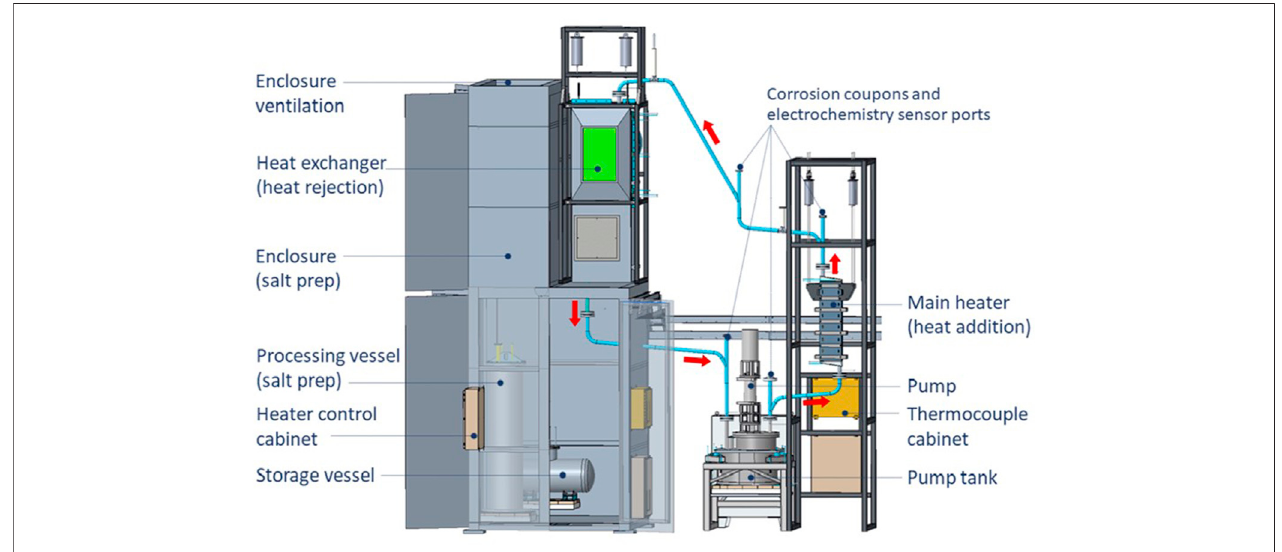
FIGURE1| Layoutofsolarsaltpumpedloop,includingavesselforsaltpreprocessing,aheater,andaheatexchangerforheatrejection.Source:Robbetal.,2019.